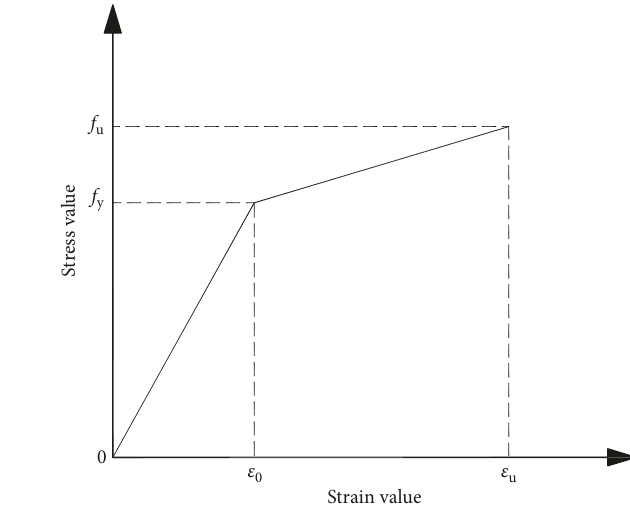
Figure 12: Stress-strain relationship for steel.